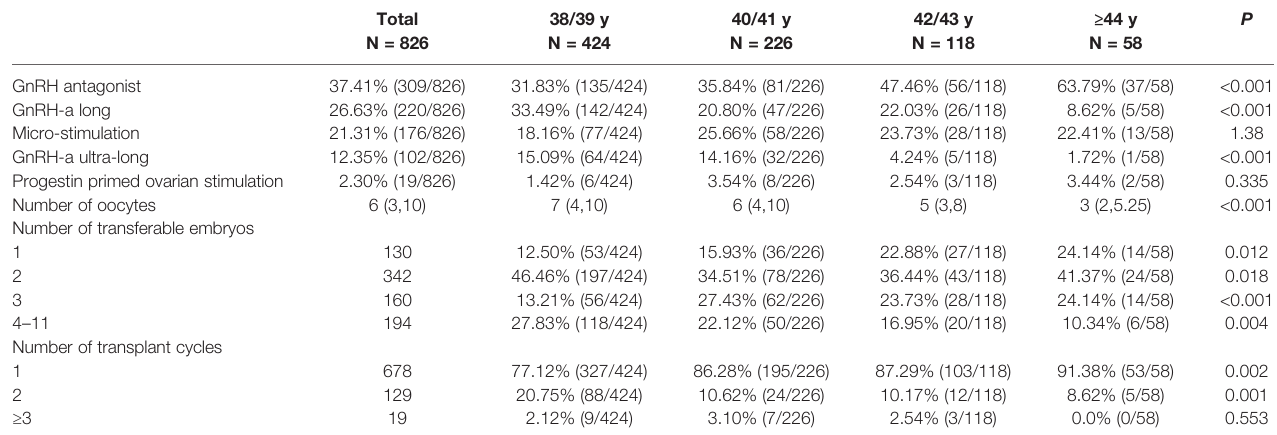
TABLE 1 | Ovarian stimulation protocols in different age brackets and data of in vitro fertilization and embryo